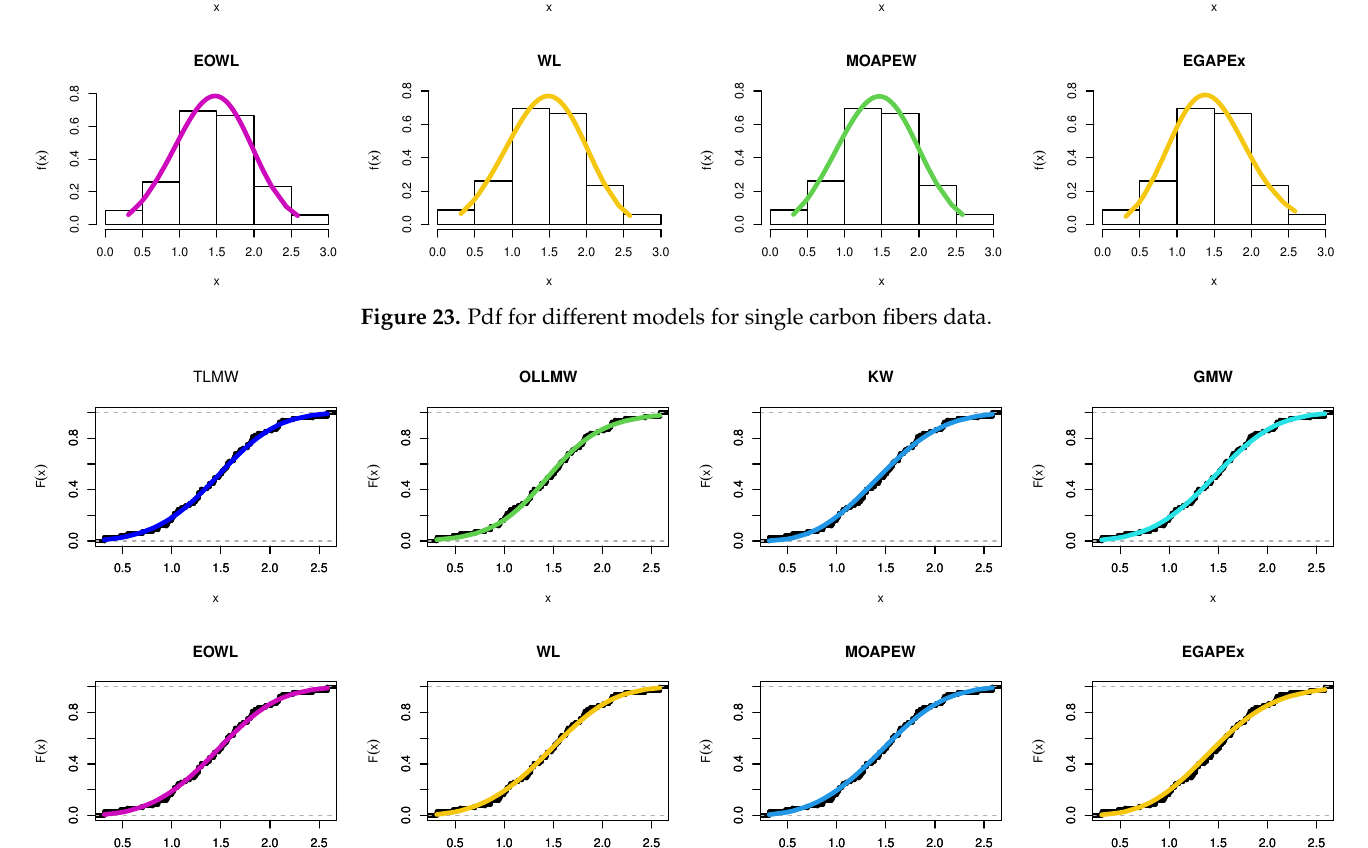
Figure 24. Cdf for different models for single carbon fibers